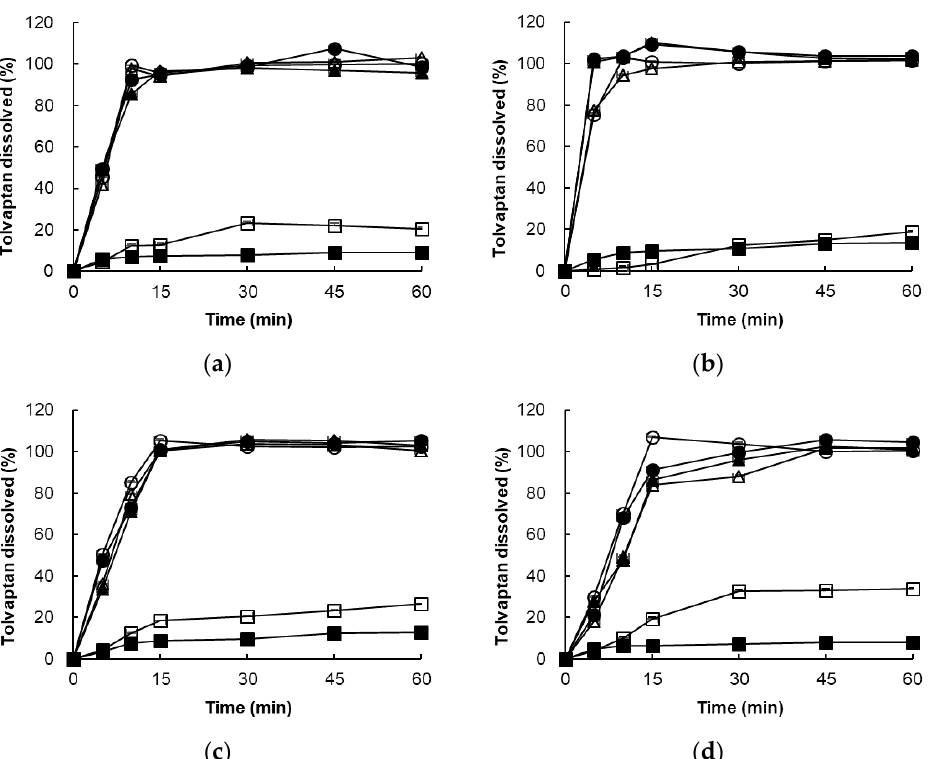
formulation A-1 (cid:35)